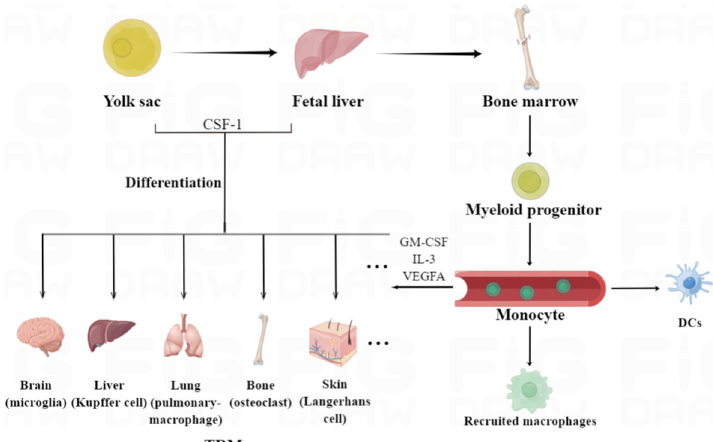
Figure 1. Origins, classification, and distribution of macrophages. Macrophages originate from yolk sac progenitors, fetal liver, and bone marrow, and can be divided into TRMs and recruited macrophages. TRMs mainly originate from the yolk sac or fetal liver or both, and can also be differentiated from monocytes in blood circulation. The recruited macrophages were mainly derived from myeloid monocytes. GM-CSF: granulocyte-macrophage-CSF; VEGFA: vascular endothelial growth factor A; DCs: dendritic